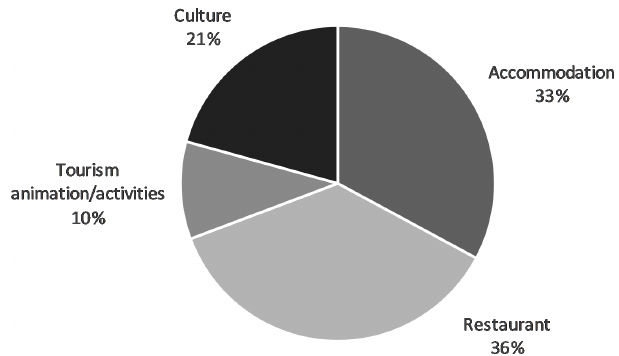
Figure 6. Percentage of buildings of each typology located in Vila Franca do Campo